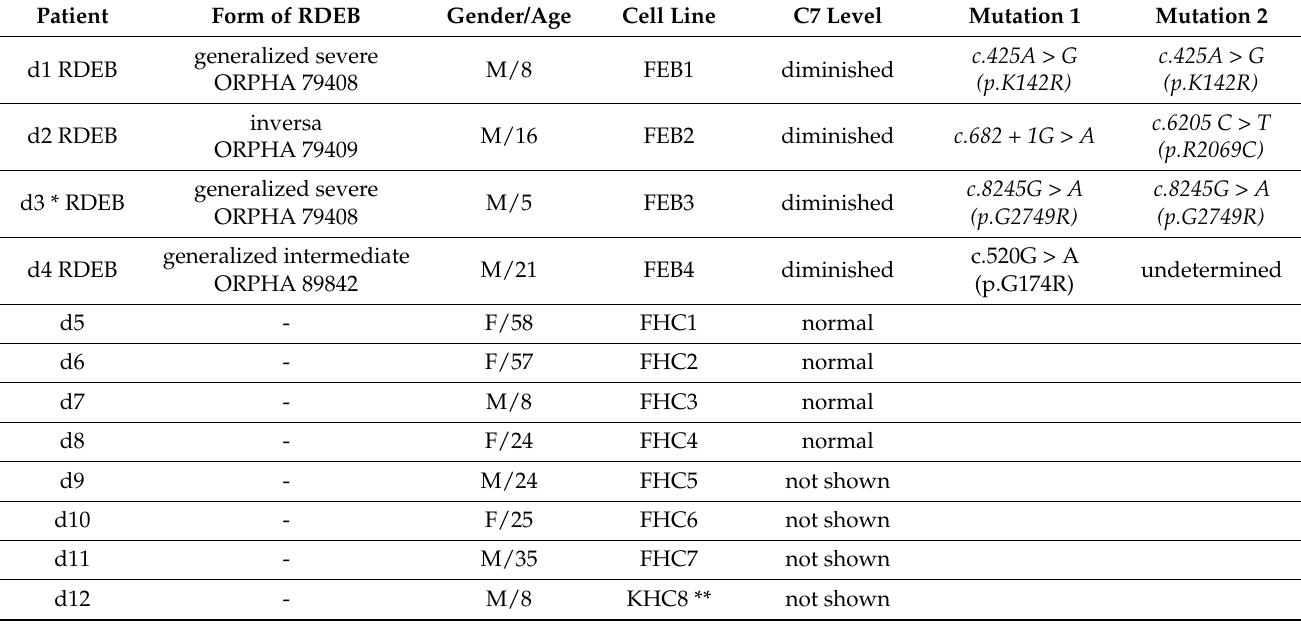
Table 1. List of patients with the recessive form of dystrophic epidermolysis bullosa (RDEB) and healthy control donors: gender and age information, numbers of patient-specific cell lines obtained and mutations identified in the COL7A1